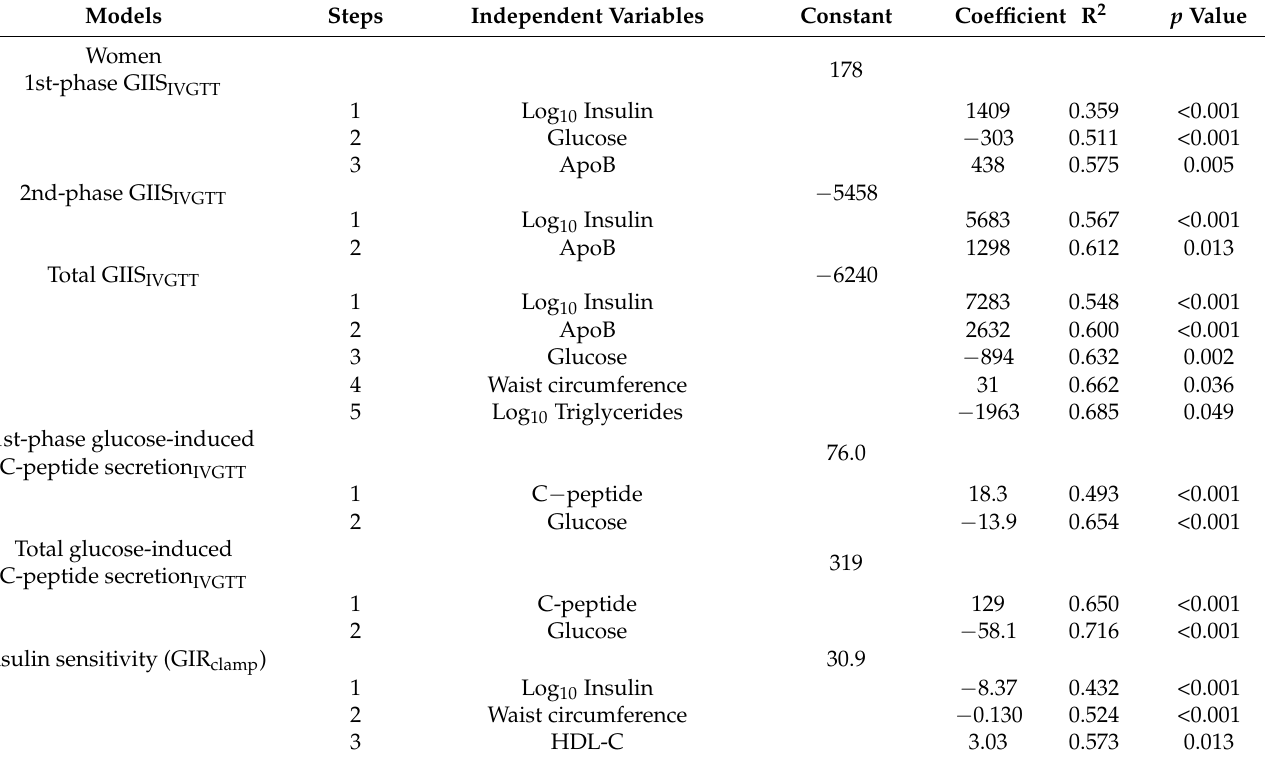
Table 2. Stepwise regression analysis to predict insulin secretion and sensitivity measured during the Botnia-clamp in women (n = 61) and men (N =